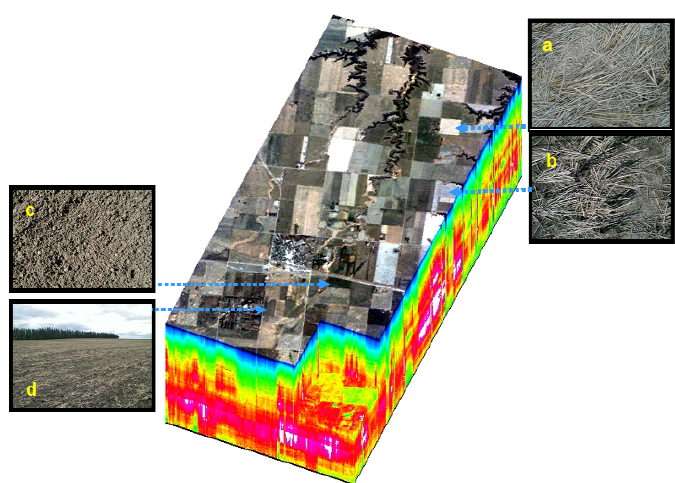
Figure 1. Study site, Indian Head, Saskatchewan (Canada).